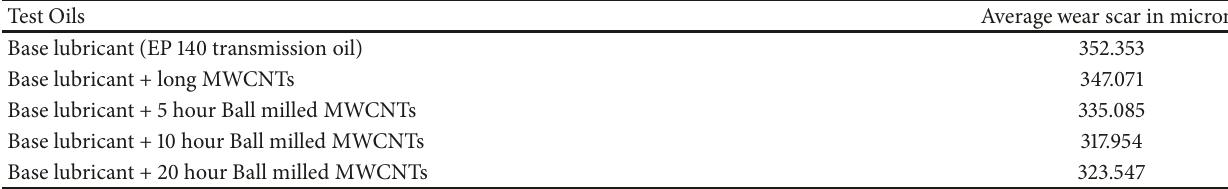
Table 4: Results of wear test conducted as per ASTM D 4172 at 40 kgf load.